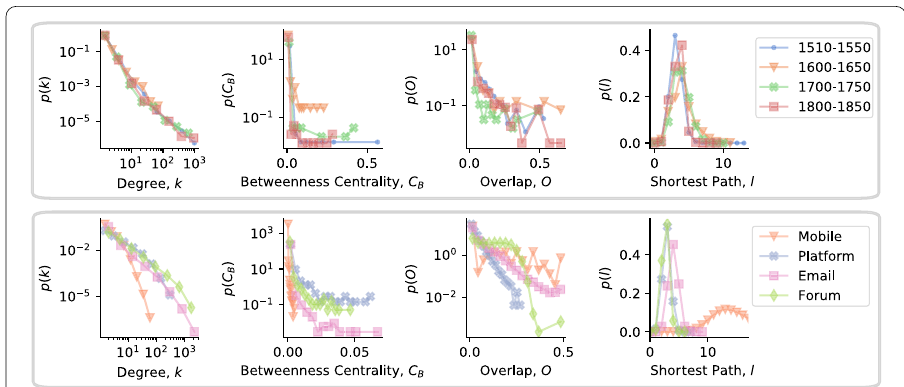
Fig. 2 Static features of communication networks, where the top (bottom) rows contains features of the correspondence (reference) networks. Epistolary datasets are aggregated in 50 year periods. Columns represent distributions of (left to right) degree k , betweenness centrality C B , topological overlap O and average shortest path length l . For ease of comparison, we do not include individual data points, but present averaged binned